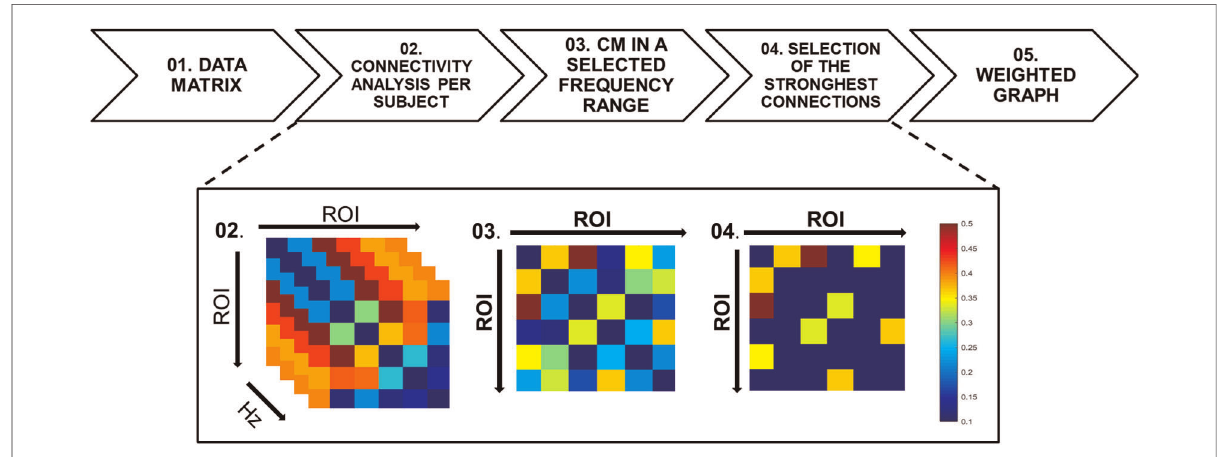
FIGURE 3 Flowchart of the functional connectivity analysis. (Top) The sequence of mathematical method used from the fMRI data matrix (step 1) to the generation of the weighted graphs (step 5). (Bottom) An example of fMRI data transformation from step 1 to 5. Step 1: for each participant, the fMRI data are represented by a matrix with dimensions N × M , in which the N dimension represents the ROIs and the M dimension represents number of samples of the time series ( N =6 and M =258). Step 2: the coherence mathematical method is performed and a frequency-varying CM in the overall frequency range [0.0012 – 0.33] Hz is obtained with a frequency step of 0.0012 Hz. Step 3: After the average of the time- varying CM in the selected frequency range of interest [0.15 – 0.33] Hz, a single CM for each participant is obtained. For group analyses, the single subject CMs are fi rst normalized in the range [0, 1], then averaged to obtain a group-level CM. Step 4: The CM is thresholded using the percentile thresholding method in order to enhance the strongest connections. Step 5: the CM is then used as an adjacency matrix for the graph extraction. The color bar indicates the connection